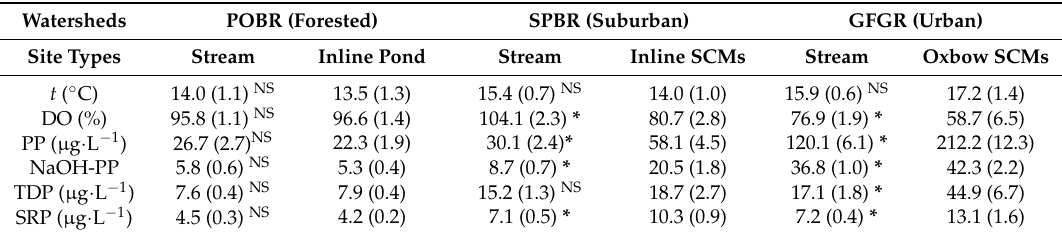
Table 2. Means (standard errors) of water temperature ( t ), dissolved oxygen saturation (%DO), and concentrations of phosphorus forms (PP, NaOH-PP, TDP and SRP) of the free-flowing stream reaches and pond/SCMs in the study